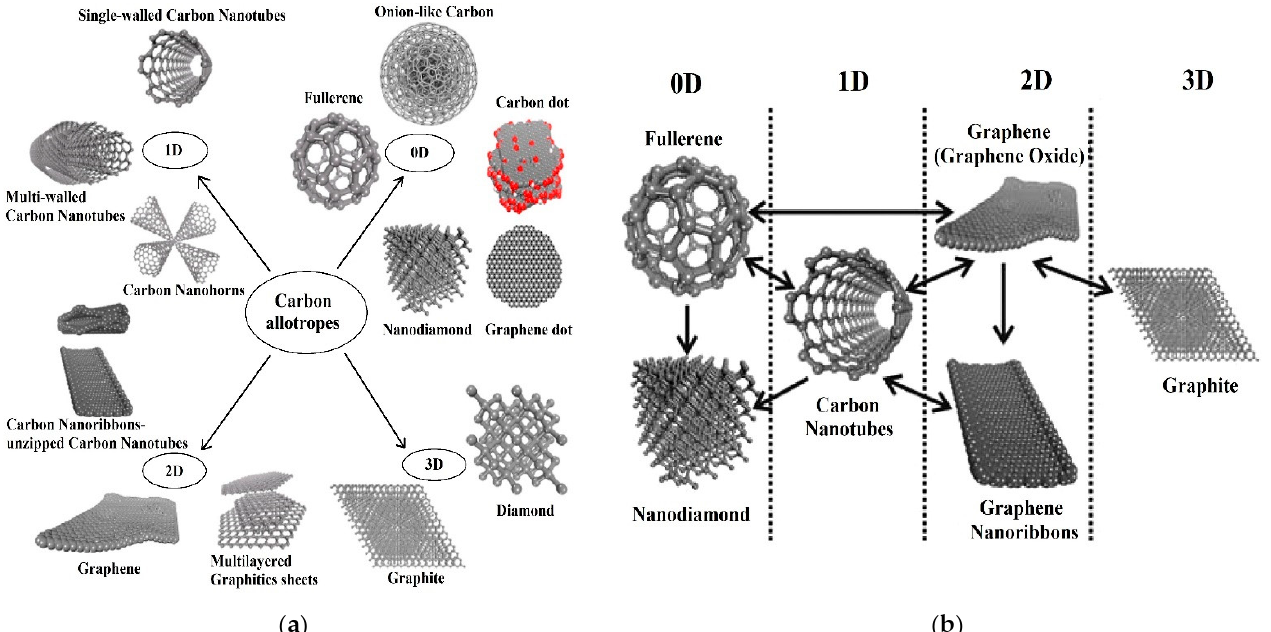
Figure 2. The structures of various allotropes of carbon ( a ), scheme which shows inter-conversion between different carbon nano-allotropes that emphasise the change in the dimension ( b ). The one-side arrow in section ( b ) reflects a transformation in one direction, while the two-sided arrow labels transformation in two directions. Reproduced with permission from [113]. Copyright © 2021 American Chemical Society.